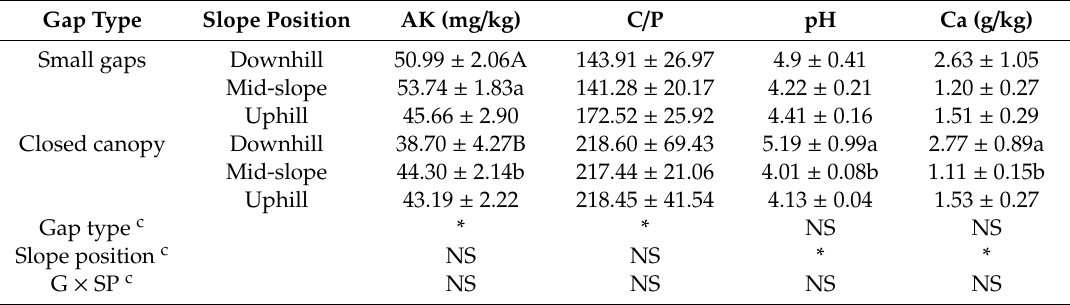
Table 2. Relationships between gap type and slope position and soil